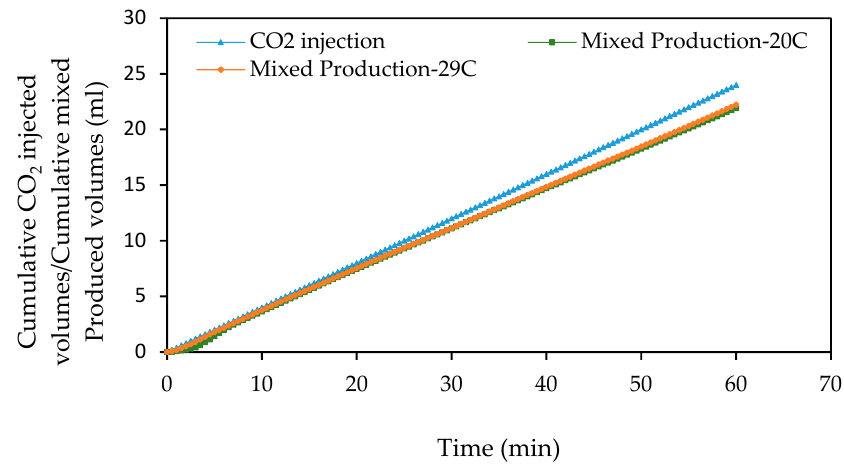
Figure 23. Effect of experimental temperature on the cumulative produced volumes of oil and CO 2 for LCO 2 –oil displacements conducted at 90 bar and 0.4 mL/min.